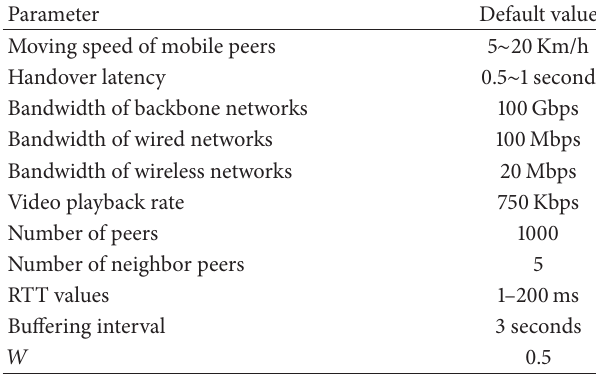
Table 1: Summary of simulation parameter